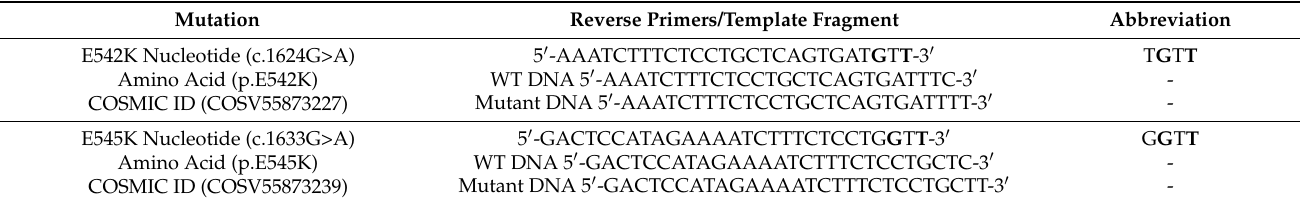
Figure 2. Allele-specific primers for the detection of E542K and E545K mutations. The mismatched nucleotides in the template are marked in red and in the AS primers in blue. The primers harbor additional mismatched nucleotides. Table 1. AS-PCR Primers for PIK3CA E542K and E545K mutation detection.